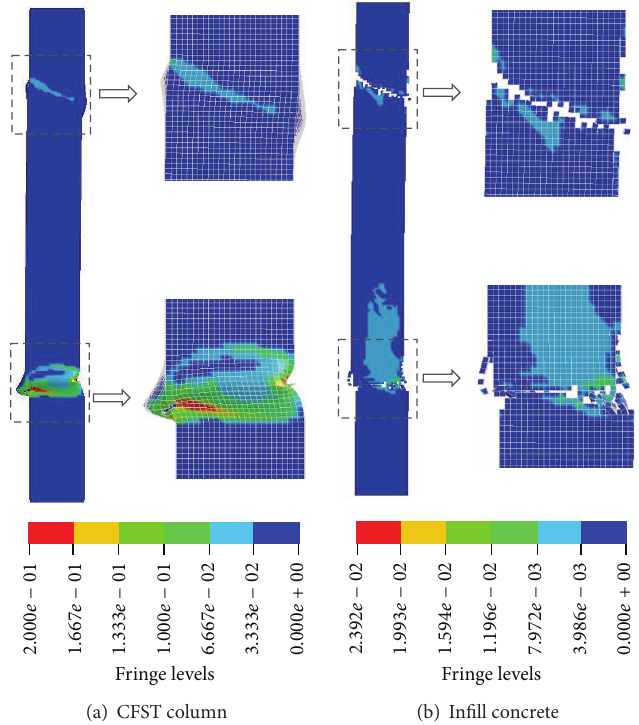
Figure 8: Shear damage mode of CFST column under blast